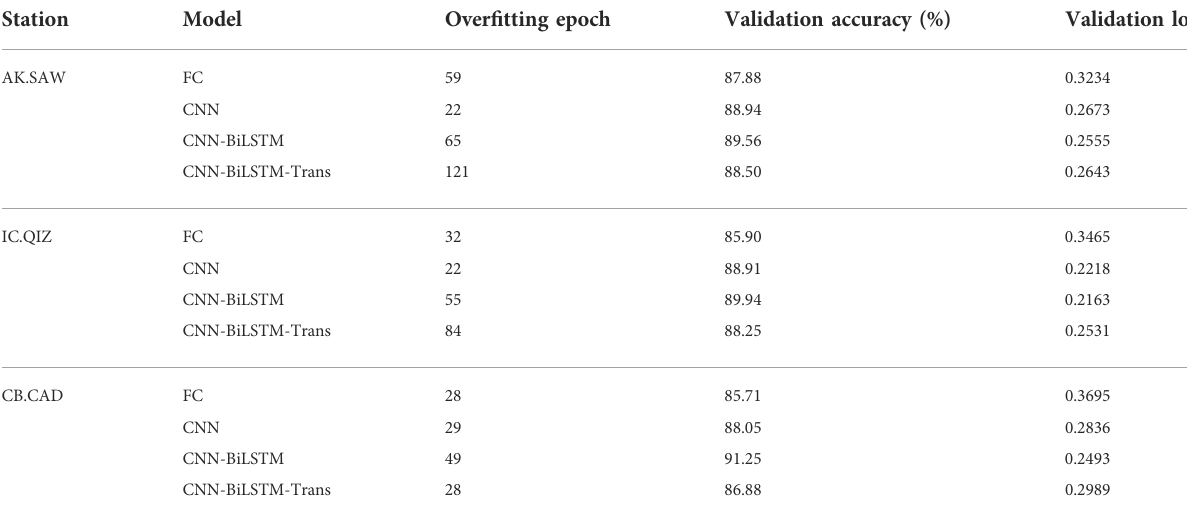
TABLE 1 The performance of the four model designs on the training and validation sets.